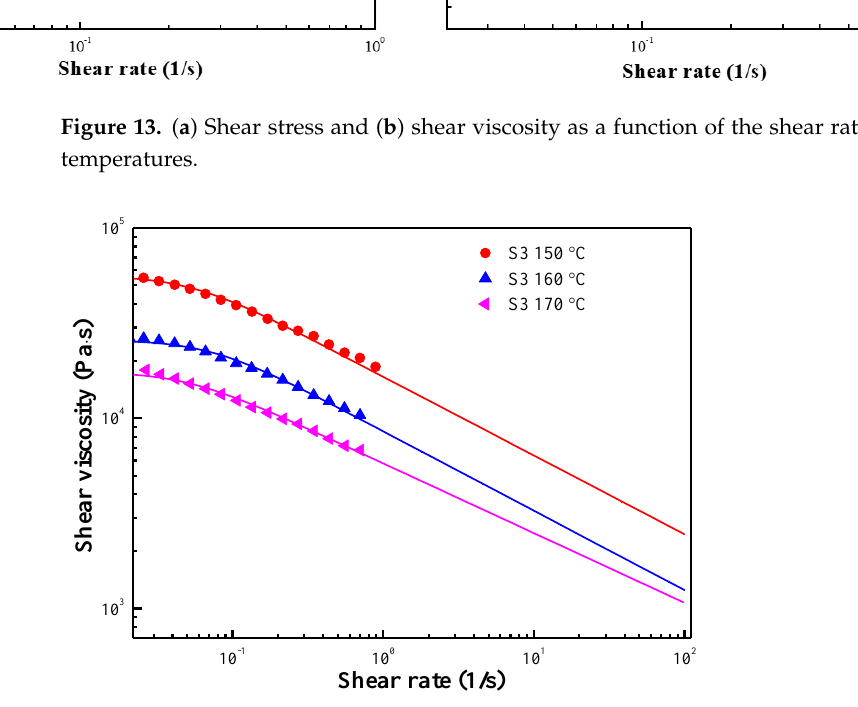
Figure 14. Shear viscosity as a function of the shear rate for S3 at various temperatures. The solid lines are fitted by the Carreau model. Table 4. Fitting parameters of the Carreau model for S3 under various temperatures.